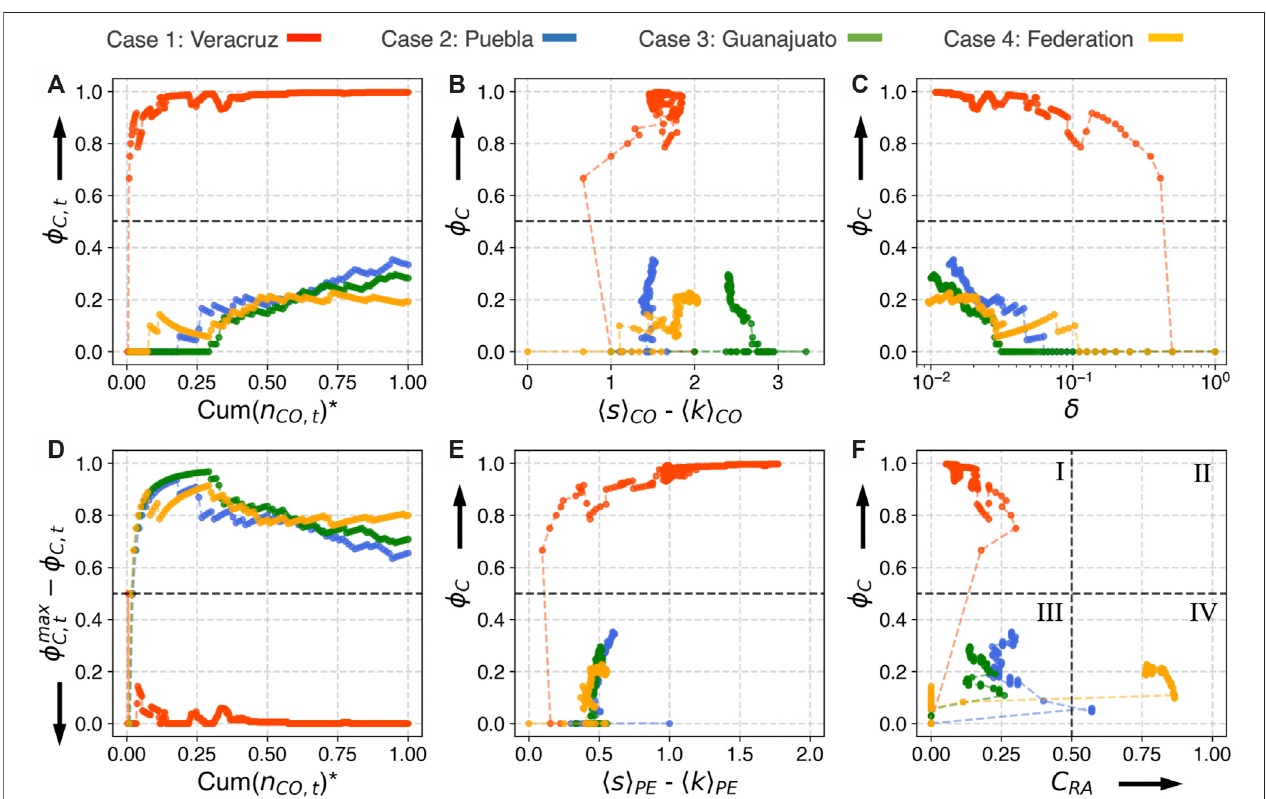
FIGURE 5 | Network-based conspiracy description. (A) Conspiracy indicator, ϕ C , t , and (B) distance to maximum conspiracy, ϕ max C , t − ϕ C , t , as a function of the normalized cumulative number of companies per year, Cum ( n CO , t ) * ; in (C – F) , time is an implicit variable of the data points for the conspiracy indicator as function of the (C) companies and (D) personnel mean strength and mean degree difference, (E) density, and (F) clustering coef fi cient. In all subplots, the arrows indicate the direction of increasing conspiracy.